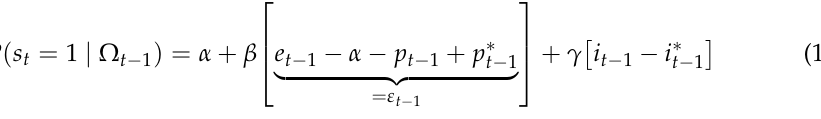
Figure 3. Real exchange rate and smoothed probability of being in the bubble regime (extended model). Note: The bold line is the real exchange rate from Equation (1). The thin black line is the